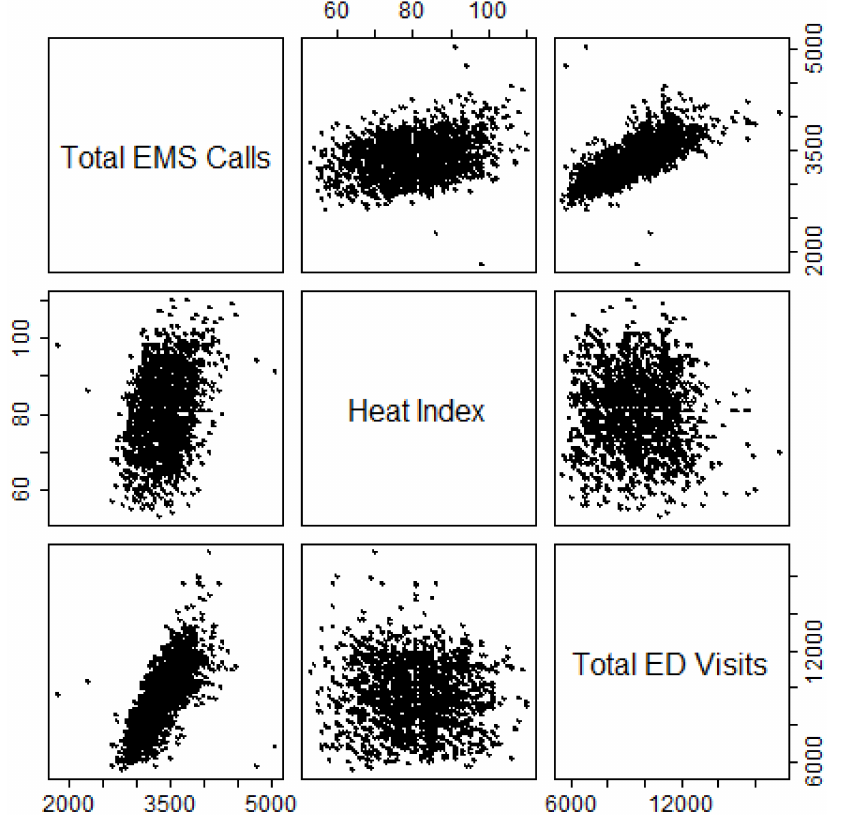
Fig 4. Scatterplot of total EMS calls, total ED visits, and maximum heat index.